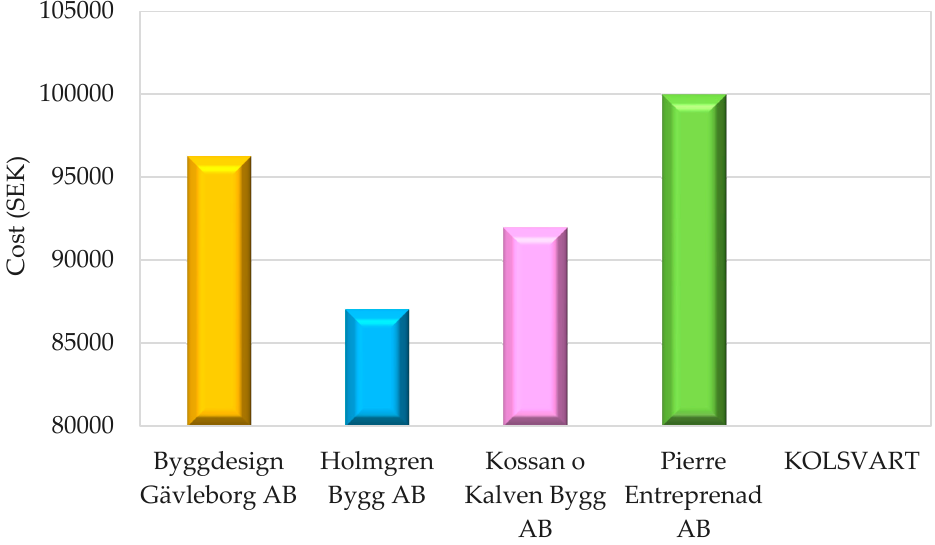
Figure 4. Differences in total costs for maintenance of a wooden facade during its working life performed by companies.